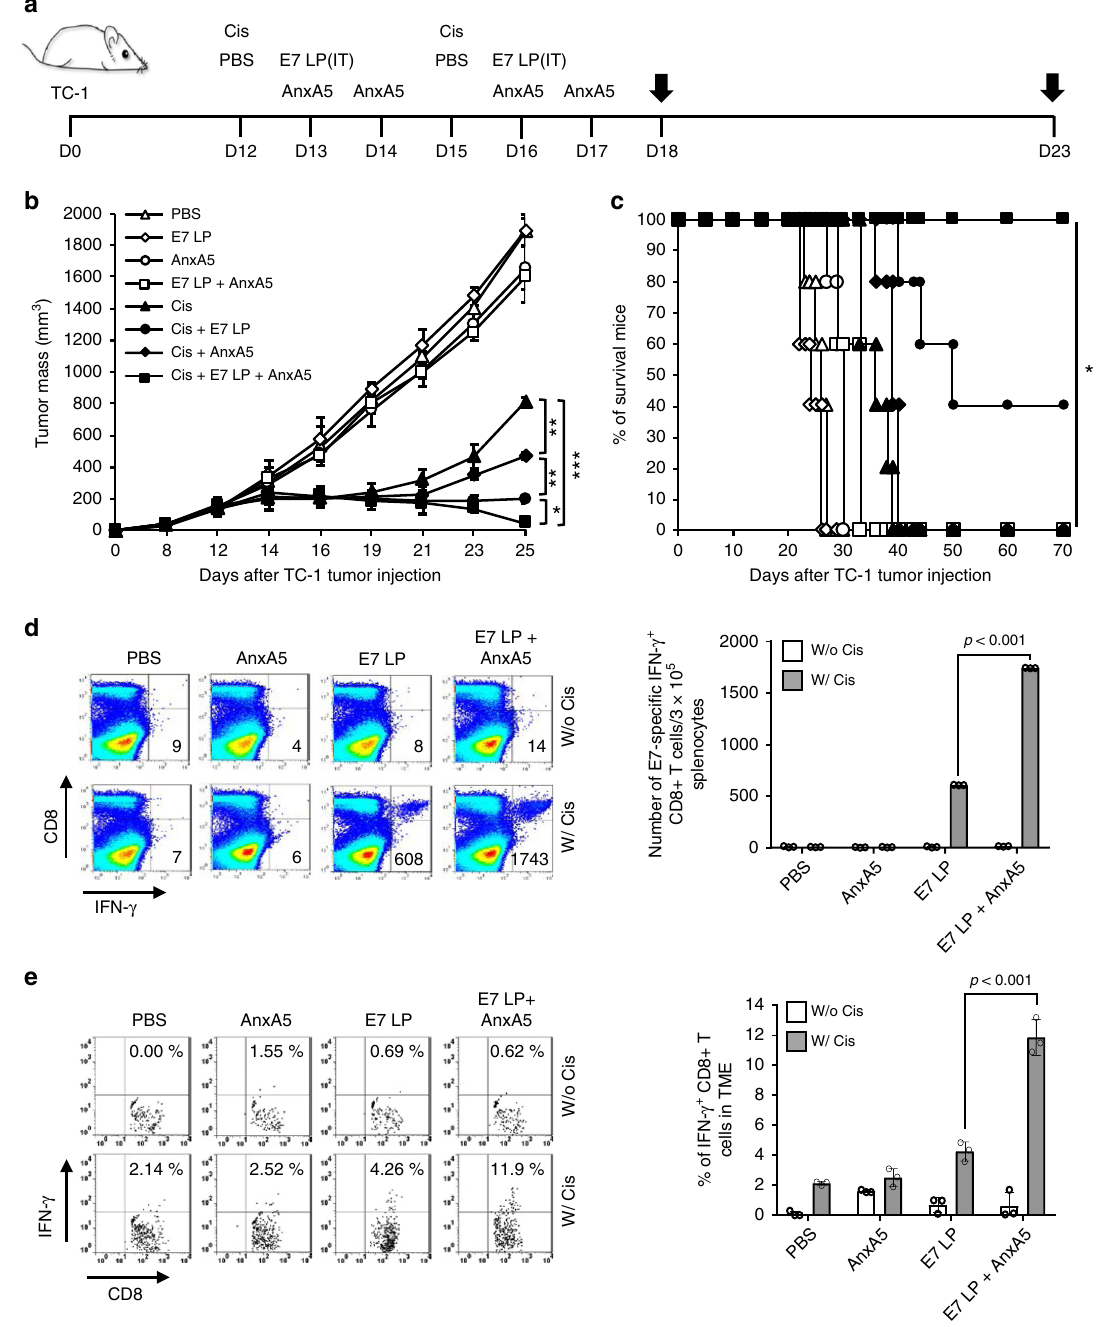
Fig. 1 Therapeutic antitumor effect of Annexin A5 protein administration. C57BL/6 mice (10 per group) were injected with 2 × 10 5 TC-1 cells/mouse subcutaneously on day 0. Mice were then treated intraperitoneally with 5 mg/kg Cisplatin on days 12 and 15, intravenously with 200jig/mice of Annexin A5 proteins on days 13, 14, 16, and 17, and/or intratumorally with 20jig/mice of E7 long peptide on days 13 and 16. The treatment groups are as follows: opened triangle - PBS only; opened sphere — E7 long peptide only; opened circle — Annexin A5 only; opened square — E7 long peptide and Annexin A5; closed triangle — cisplatin only; closed circle — cisplatin and E7 long peptide; closed sphere — cisplatin and Annexin A5; closed square — cisplatin, E7 long peptide, and Annexin A5. a Schematic diagram. b Line graph depicting TC-1 tumor growth in different treatment groups over time ( n = 10). P -values were determined by one-way ANOVA and Turkey ’ s test. c Kaplan – Meier survival analysis of TC-1 tumor-bearing mice in different treatment groups and the overall P -value was calculated by the log-rank test ( n = 10). d, e On days 18 and 23, tumor tissues and spleens of TC-1 tumor-bearing mice in different treatment groups were harvested and analyzed for CD8 + IFN- γ + T cells by fl ow cytometry analysis, respectively. d Representative fl ow cytometry analysis and bar graph depicting the abundance of CD8 + IFN- γ + T cells in splenocytes of TC-1 tumor-bearing mice in different treatment groups. e Representative fl ow cytometry analysis and bar graph depicting the abundance of CD8 + IFN- γ + tumor-in fi ltrating T cells in TC-1 tumor-bearing mice in different treatment groups. The error bars indicate mean ± SD. P -values were analyzed by Student ’ s t test ( n = 3). The results are representative of one of three independent experiments. Source data are provided as a Source Data fi